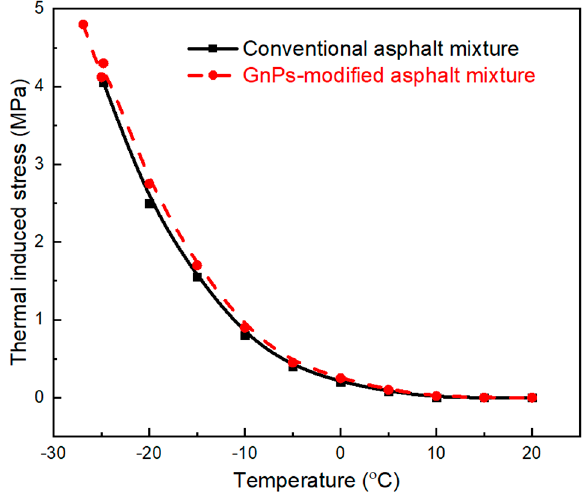
Figure 11. Thermal induced stress of unmodified asphalt mixtures and GnPs-modified asphalt mixture. Table 3. TSRST results for modified and unmodified asphalt mixture.